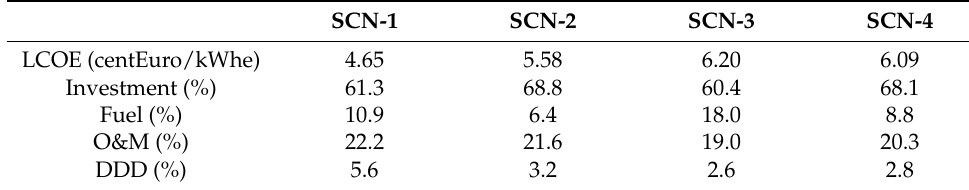
Table 8. Summary of costs calculated by Rodr í guez et al. [38] for their four scenarios.